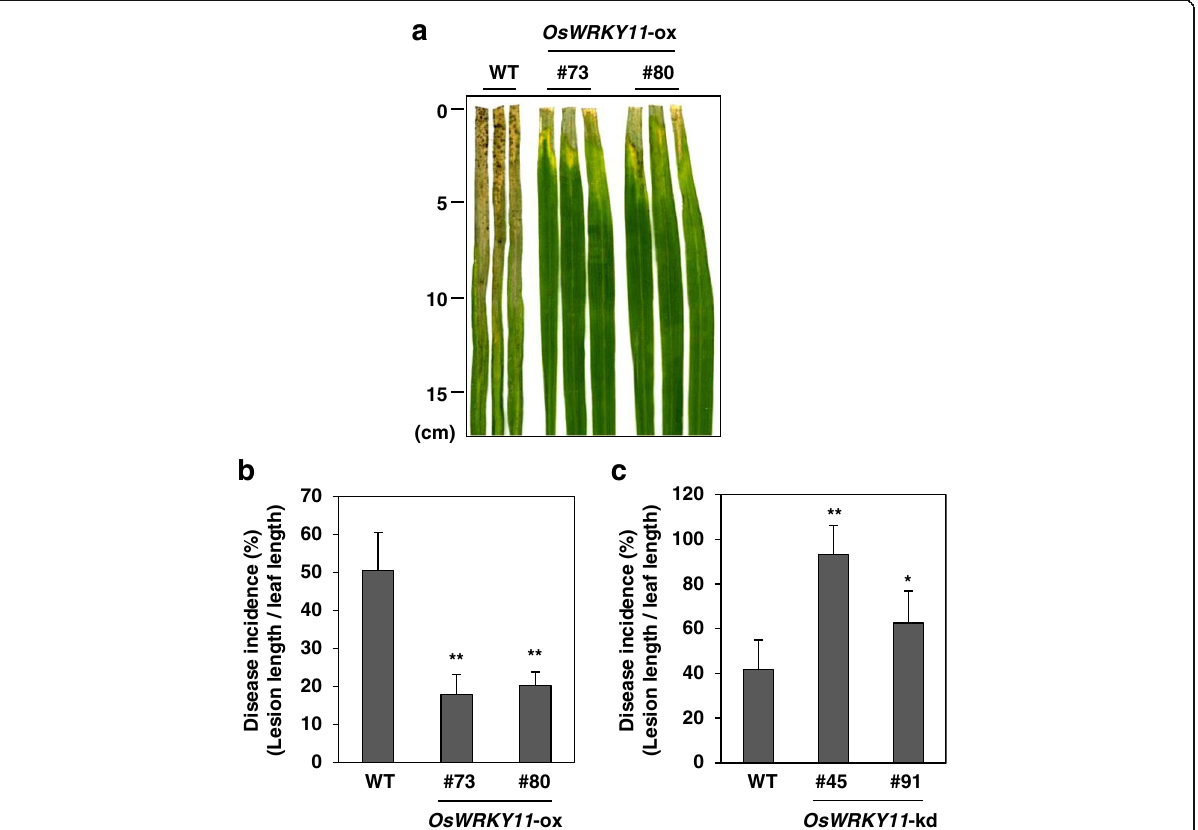
Fig. 2 Analysis of OsWRKY11 -ox and RNAi (kd) plants in response to Xoo infection. Wild-type (WT) and transgenic lines (T2) over-expressing or under-expressing OsWRKY11 were challenged with Xoo using the leaf-clip method and photographed at 14 dpi ( a ). Lesion lengths were measured at 14 dpi, and disease incidences for OsWRKY11 -ox ( b ) and OsWRKY11 -kd lines ( c ) were expressed as the percentage of lesion length/leaf length. Asterisks indicate significant differences from the WT (**: P < 0.01; *: P < 0.05)